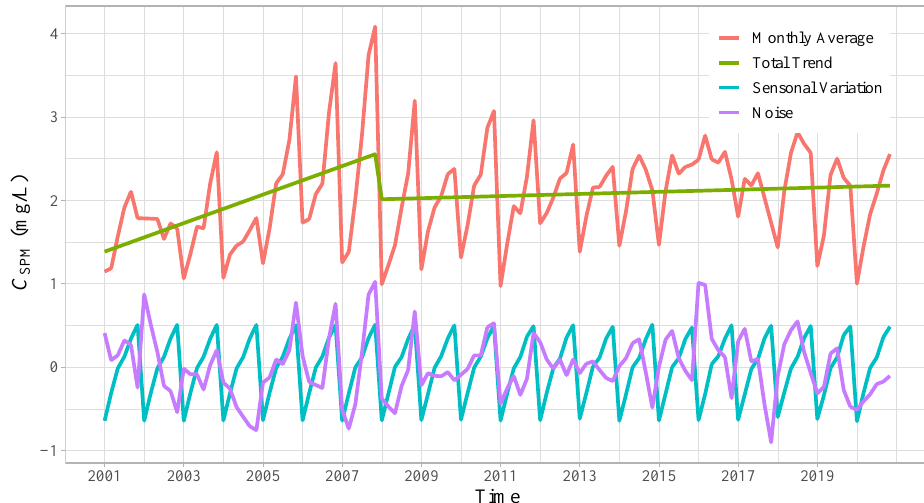
Figure 10. Temporal variation of monthly mean C SPM wtih BFAST